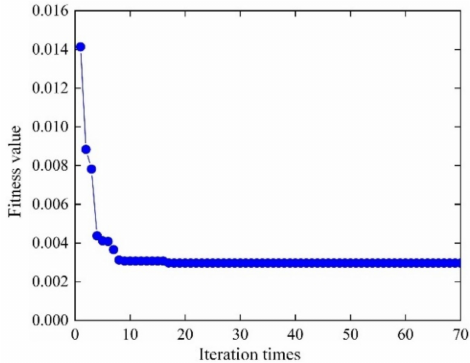
Figure 17. DMIGA optimization process of collaborative IKM.